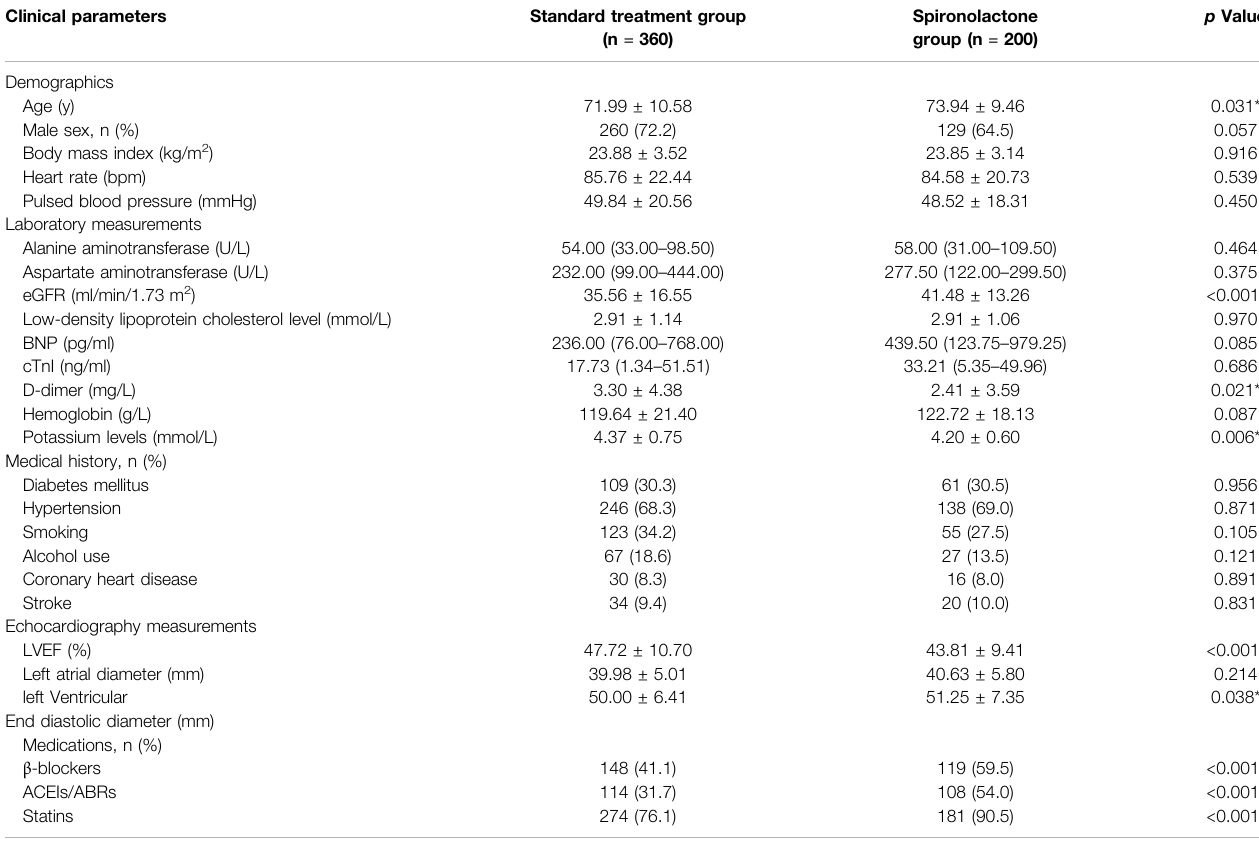
TABLE 1 | Baseline clinical characteristics of patients. Clinical parameters